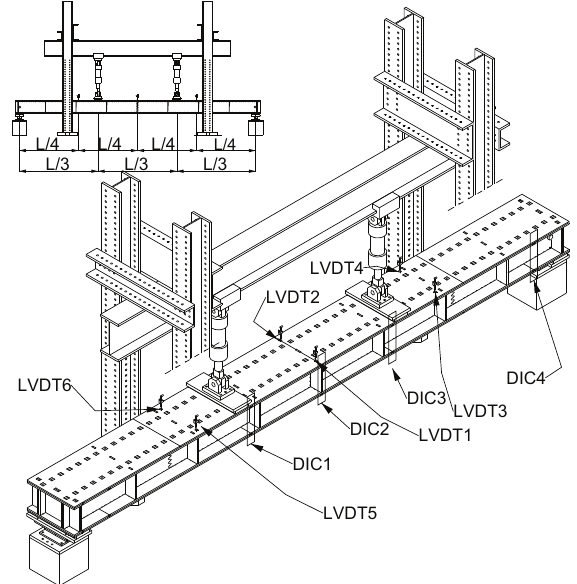
Figure 2. Four-point bending test setup for large-scale specimens. DIC, digital image correlation.